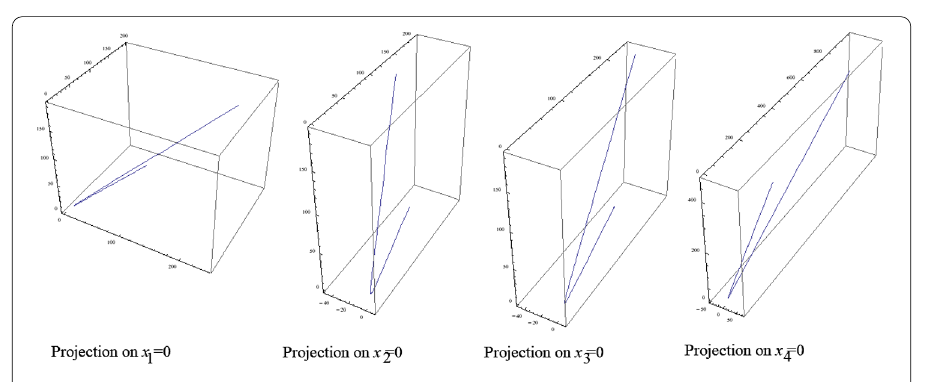
Figure 2 x ( s ) = (cosh s + 5